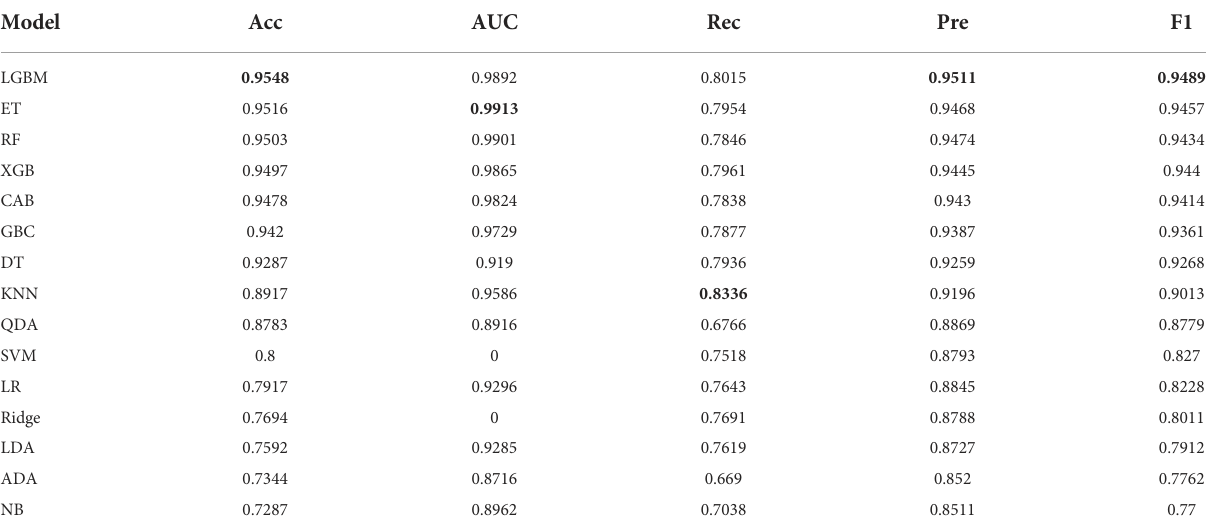
TABLE 3 Performance comparison.